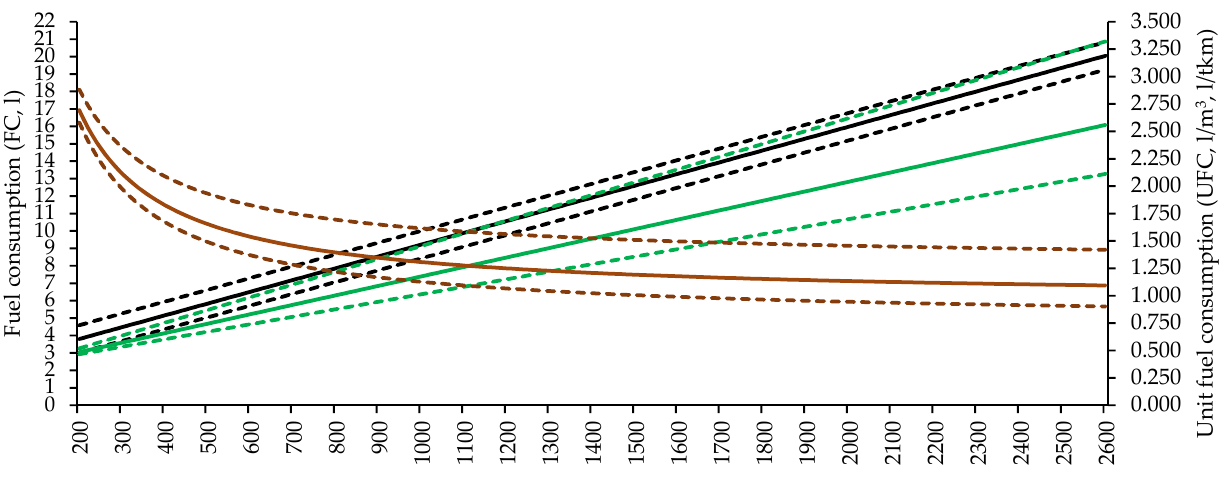
Figure 3. Simulated productivity and efficiency. Note: black lines stand for productivity and green lines stand for efficiency; continuous lines stand for the estimated figures and dashed lines stand for standardized uncertainty.